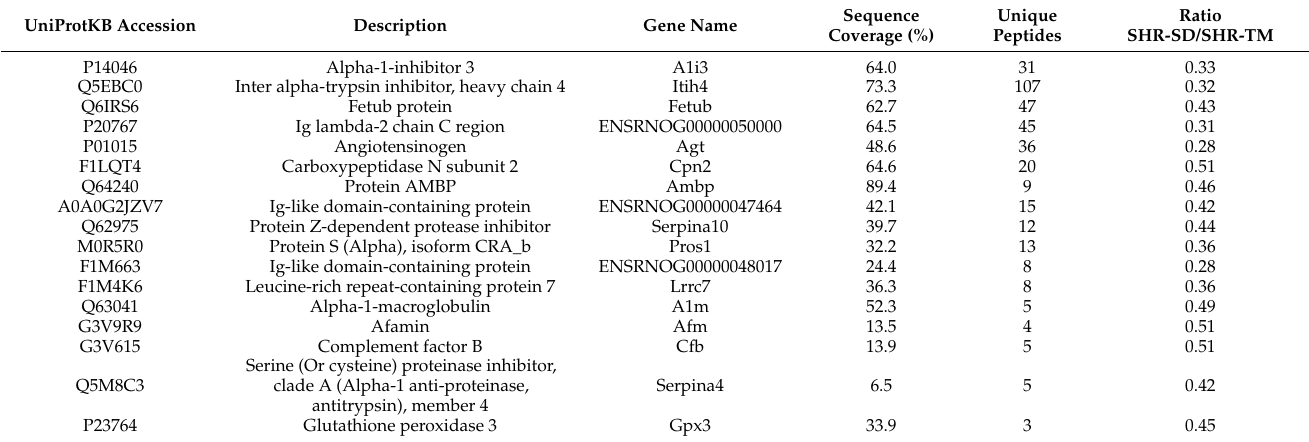
Table 2. List of 17 identified and relatively quantified proteins reversed by Tenebrio molitor sup- plementation in SHR-TM rats. The table reports the UniProtKB accession number, gene name, description, sequence coverage (%), number of unique peptides, and relative expression value (i.e., SHR-SD/SHR-TM ratio).